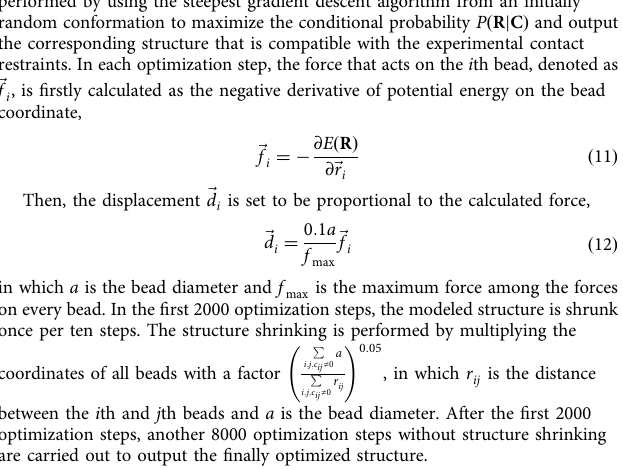
between the i th and j th beads and a is the bead diameter. After the fi rst 2000 optimization steps, another 8000 optimization steps without structure shrinking are carried out to output the fi nally optimized structure. Hierarchical optimization strategy . The optimized structure of low resolution is used to generate the initial structure of high resolution for another optimization procedure to obtain high-resolution optimized structure. There are two steps for deriving a high-resolution initial structure from the optimized structure of low resolution. First, each bead of the optimized structure of low resolution is evenly divided into two small beads. Second, based on the coordinates of the i th and i + 1th parent beads in the low-resolution structure, denoted as ~ r i ; low and ~ r i þ 1 ; low , we de fi ne the coordinates of the two small derived beads from the i th parent